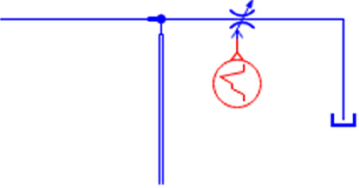
Figure 13. Simulation principle of pipe joint leakage. Table 10. Pipe joint leakage under different working conditions.